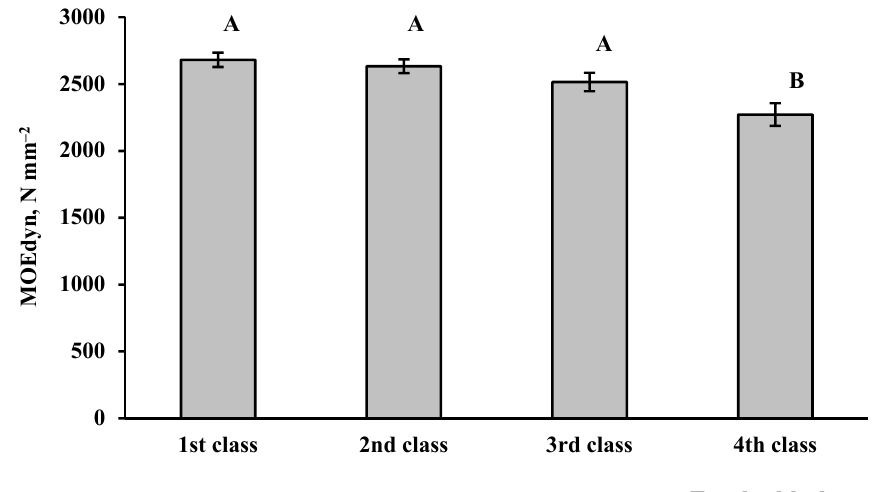
Figure 5. Mean values of the dynamic modulus of elasticity (MOEdyn, N mm − 2 ) of urban small-leaved lime trees, corresponding to different health classes. Bars show the standard error of the mean. Different capital letters at the top of the columns show statistically significant differences between the different health classes at p < 0.05.